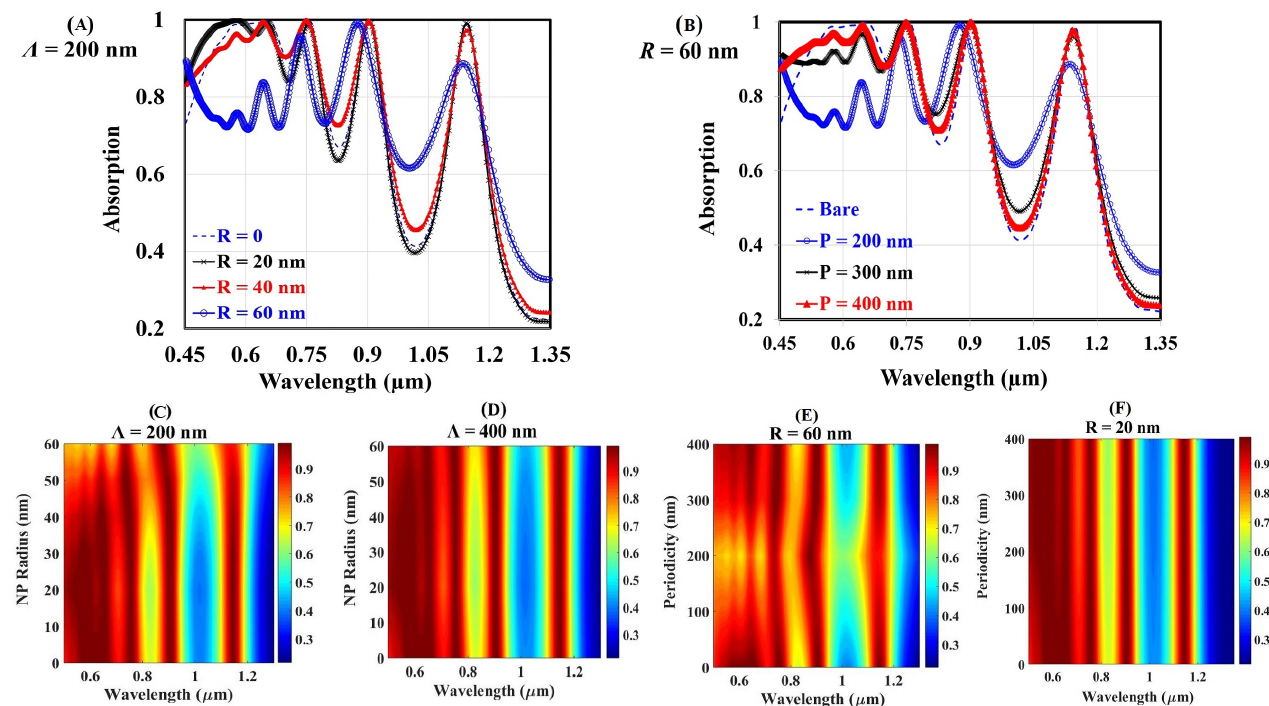
Figure 4. The modification of the absorption spectra due to ( A , C , D ) changing the Al nanoparticle radius and ( B , E , F ) changing the structural periodicity.